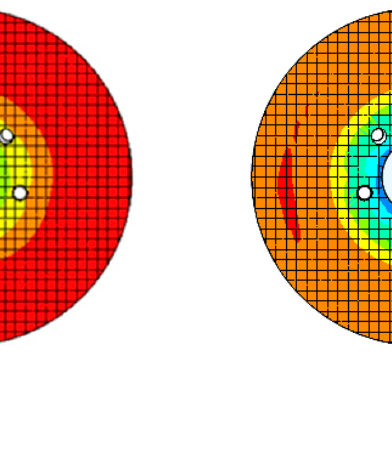
(d) Figure 7. Simulation results of the surface temperature of each component. ( a ) Copper disk surface. ( b ) Backing yoke disk surface. ( c ) Aluminum disk surface. ( d ) Permanent magnet surface. 5. Test Verification Establishment of Test Platform To verify the temperature rise caused by the torque and heat loss of the magnetic coupler, a 1:1 prototype of the magnetic coupler was trial-produced and a test platform was built, as shown in Figure 8. The test platform mainly consists of a servo motor (man- ufacturer: GUO MAI; Model: 130-15025) and its accessories, a pulse generator, a dynamic torque sensor for measuring torque and speed (manufacturer: YANG GE; model: DYN- 200, Sensitivity:2.0 MV/V), a magnetic powder brake for providing different loads (man- ufacturer: WUXI Odek; Model: PB-5) and its accessories, a tension controller (precision:0.1 N·m), a rotating precision table for air gap size adjustment, etc. The magnetic coupling prototype and the test bench are shown in Figure 7. In the test, the conductor disk is con- nected to the servo motor side, and the permanent magnet disk is connected to the mag- netic powder brake side.